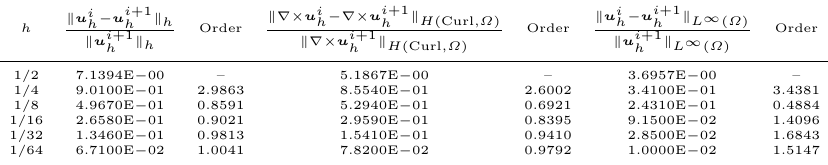
Table 3. Results for the C 0 interior penalty method for Experiment 4.2.